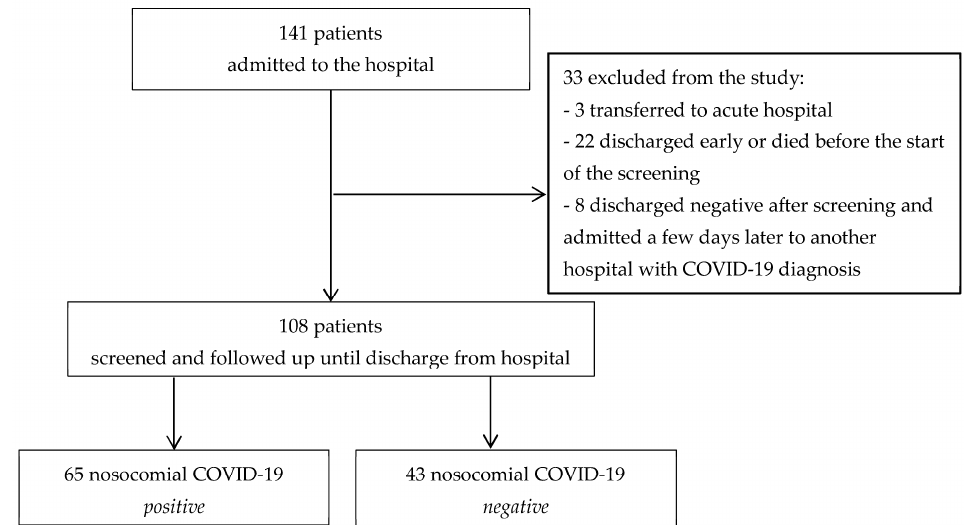
Figure 1. Protocol of the screened patients for their inclusion in the study.